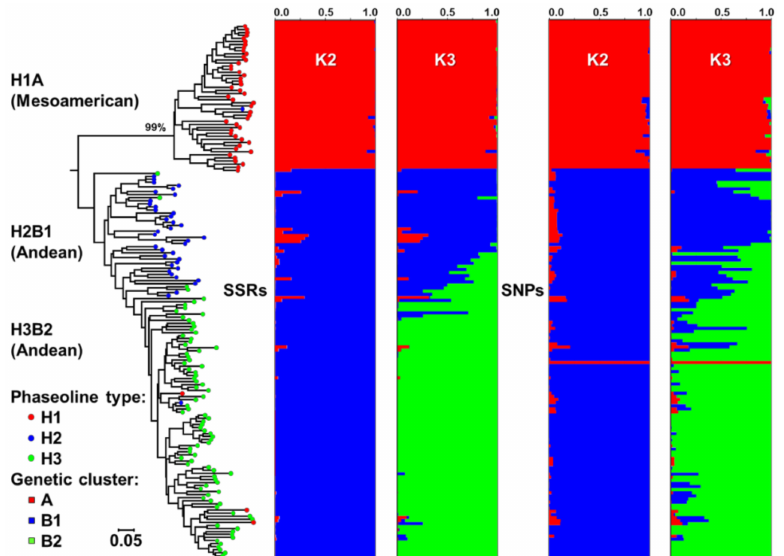
Figure 1. Neighbour-Joining tree of 174 Croatian common bean accessions based on SSR markers and the average proportions of membership at K = 2 and K = 3 as estimated by STRUCTURE using SSR and SNP markers. Phaseolin type of the accessions is indicated on branches of the tree. Bootstrap percentages above 50% based on 1000 replicates are indicated only for major